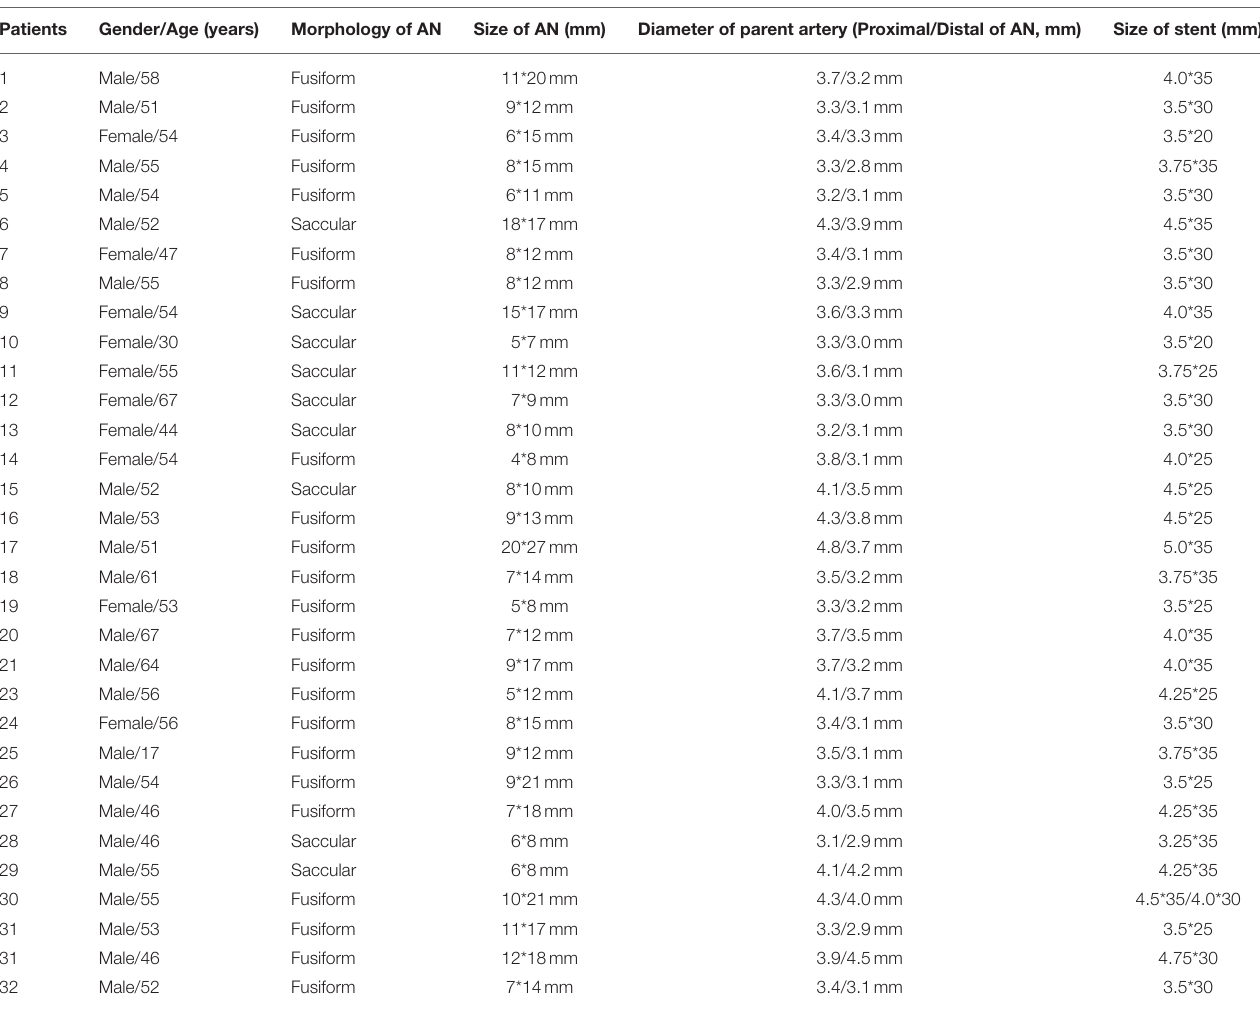
TABLE 2 | Patients, aneurysm and stent details.